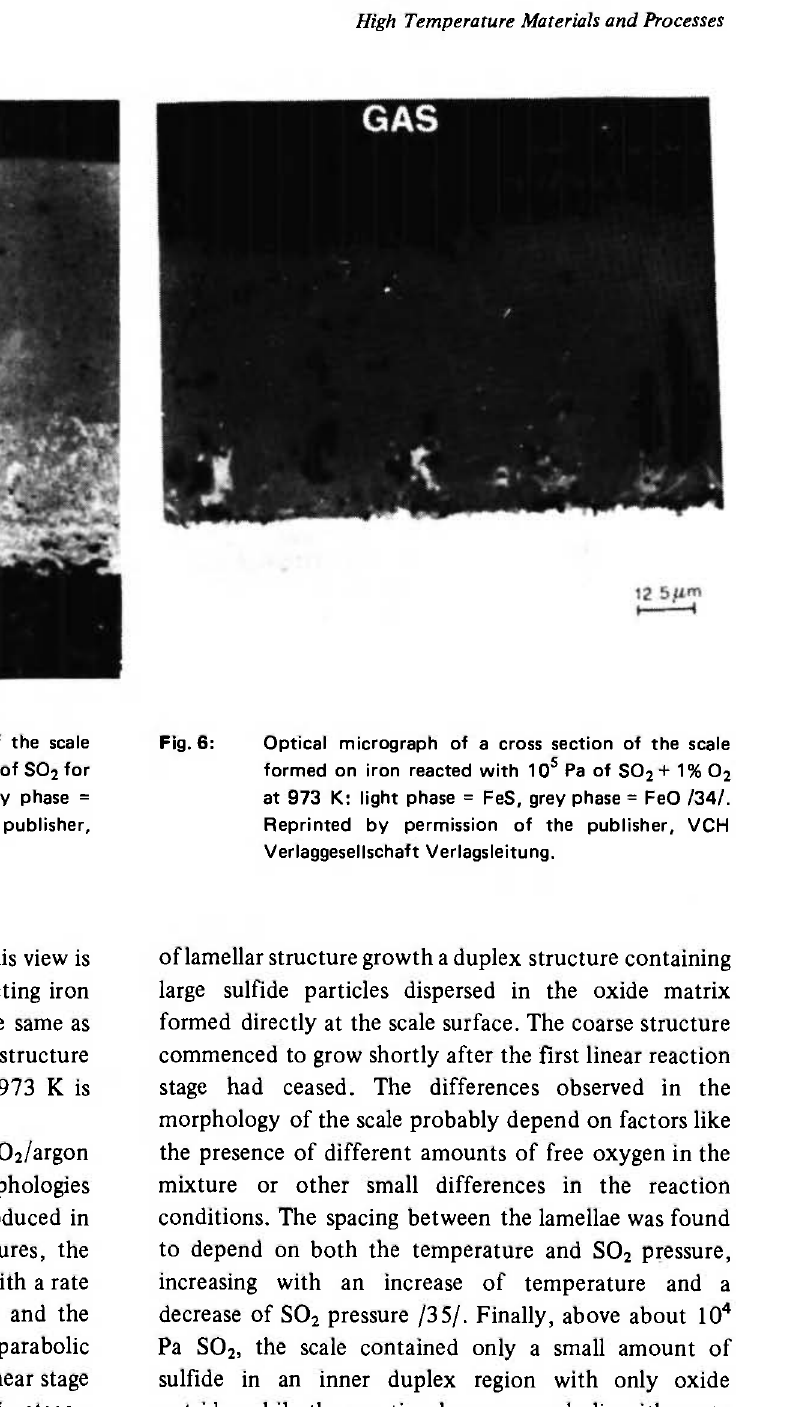
Fig. S: Optical micrograph of a cross section of the scale formed on manganese reacted with 10 5 Pa of S 0 2 for 6 hr at 1173 K: light phase = MnS, grey phase = MnO /29/. Reprinted by permission of the publisher. Plenum Press.